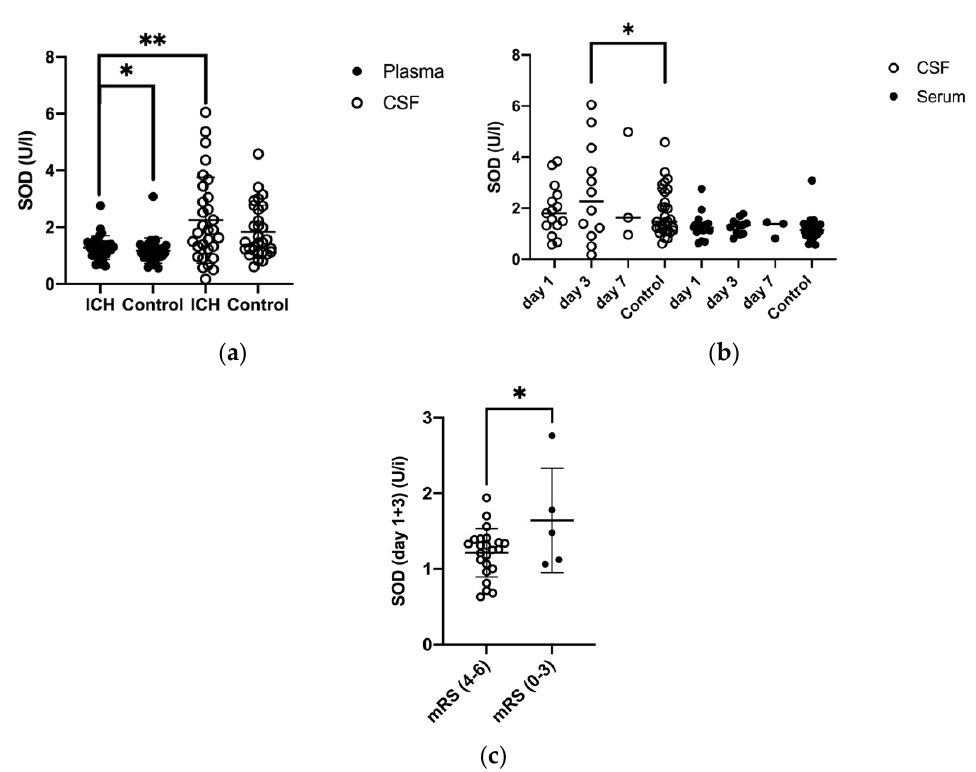
Figure 1. ( a ) Comparison of mean SOD levels in plasma (P) and cerebrospinal fluid (CSF) in ICH patients and control group, SOD (P) in ICH and control: p = 0.023, mean SOD (P) and mean SOD (CSF): p = 0.008 ( b ) Development of SOD levels in P and CSF in ICH patients and control group (day 1, day 3, and day 7), SOD (CSF) at day 3 and control: p = 0.02 ( c ) Comparison of SOD in P (day 1 and